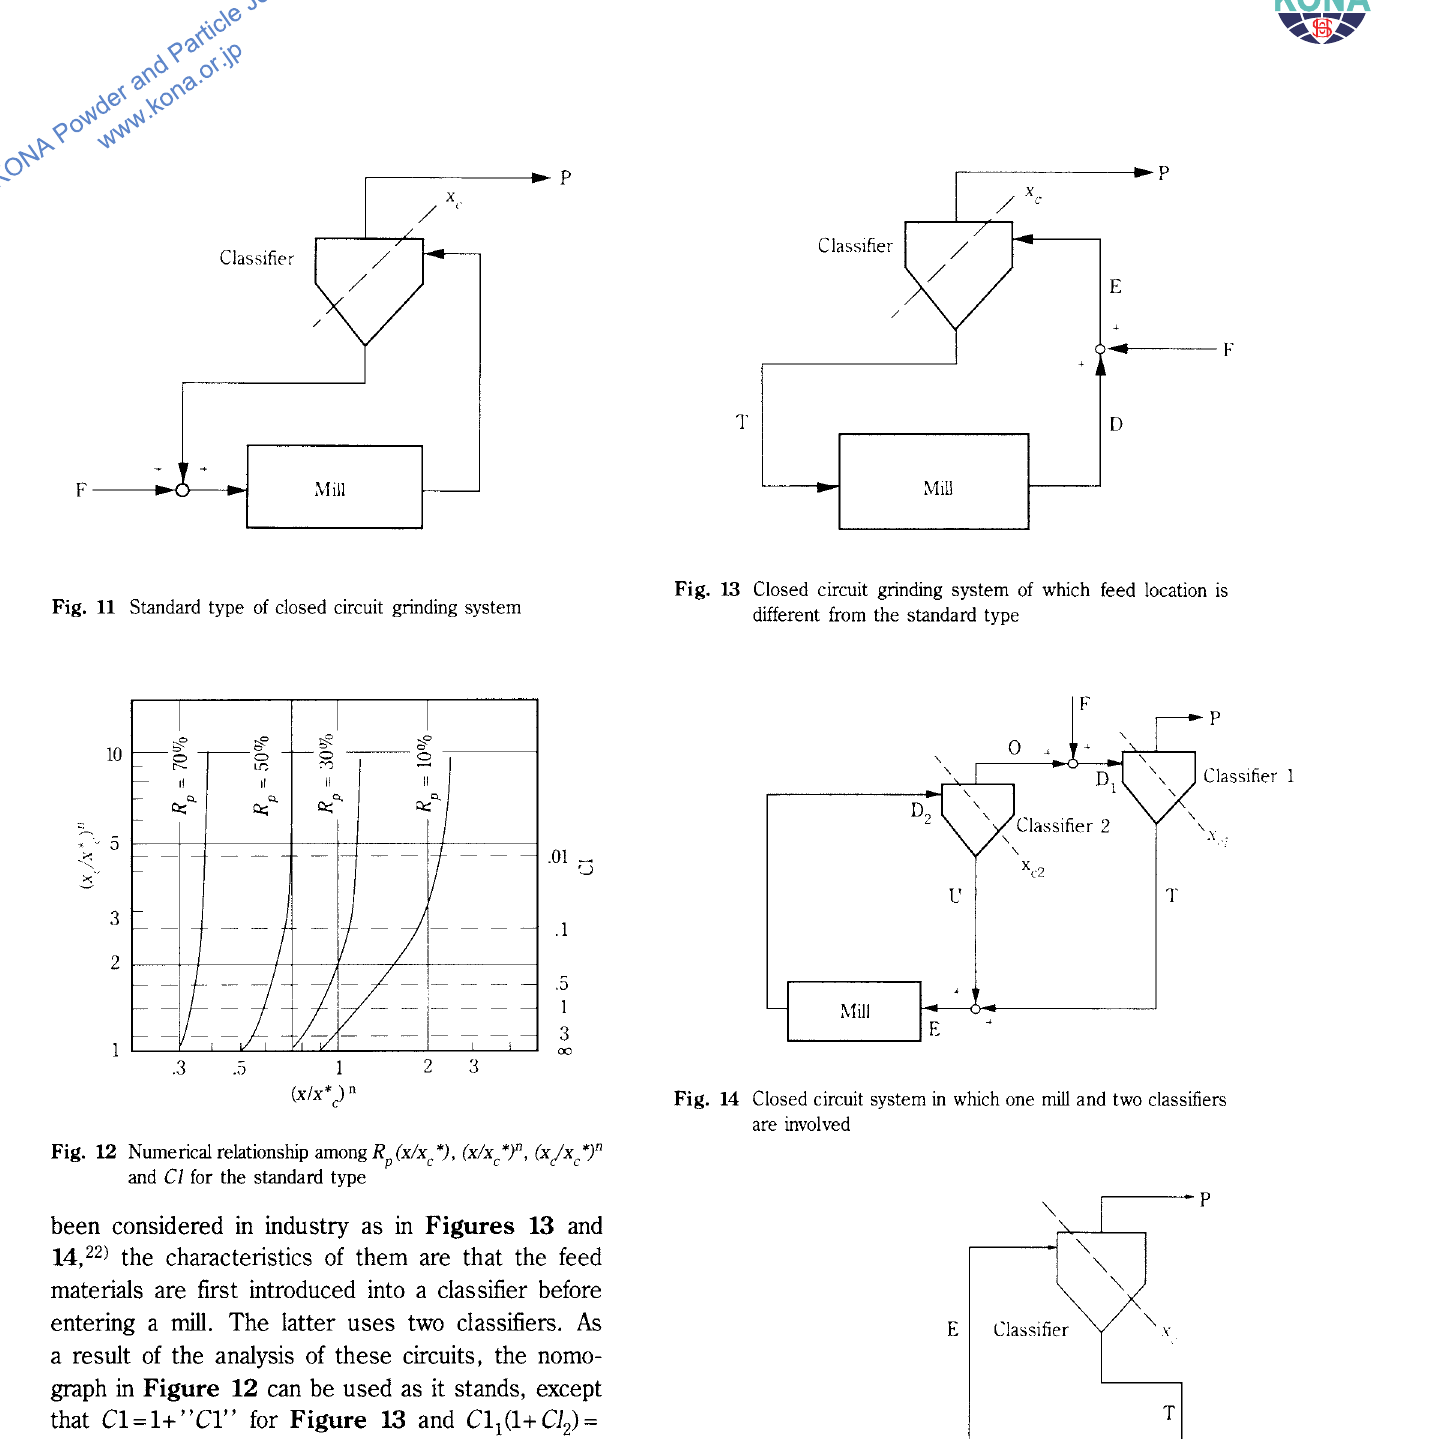
Fig. 12 Numerical relationship among R/xlxc *), (x!xc *)n, (x/xc •yn